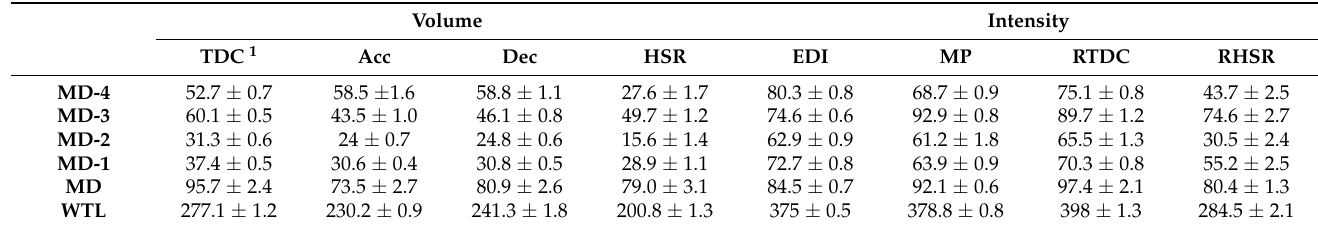
Table 3. Volume and intensity markers represented as a % according to the profile competitive. Volume